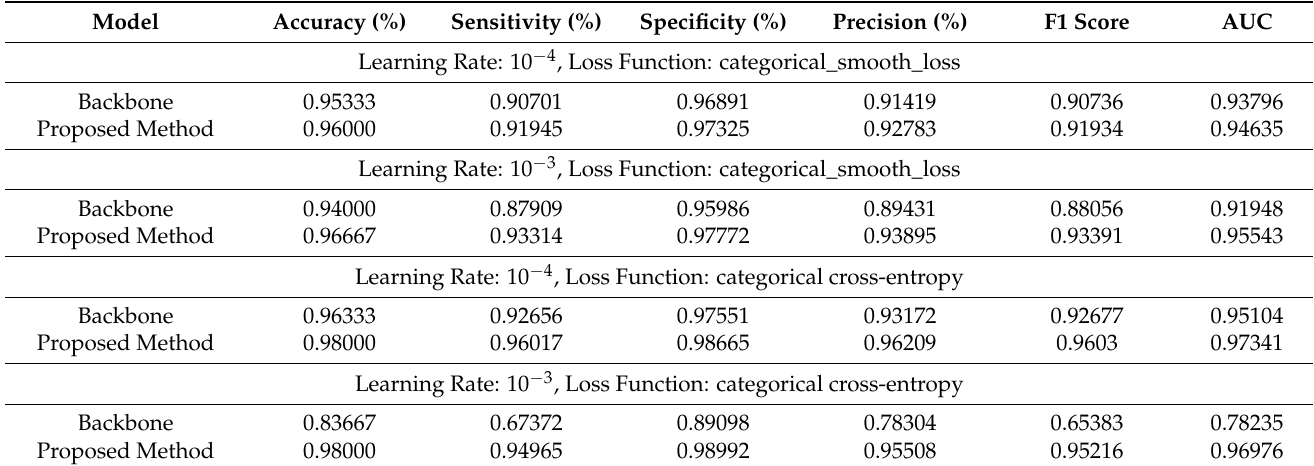
Table 7. Classification results of the backbone vs. proposed model using